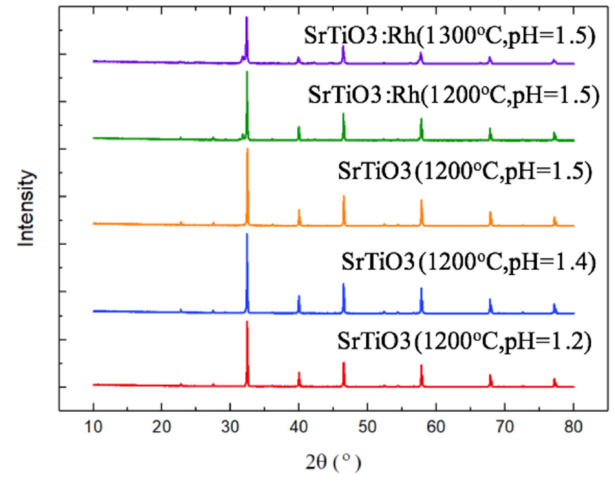
Figure 7. XRD results of the in-house synthesized catalysts. Different colors indicate different materials and different preparation conditions. The temperature indicates the calcination temperature of the materials and the pH value indicates the solution pH value during the sol–gel process.